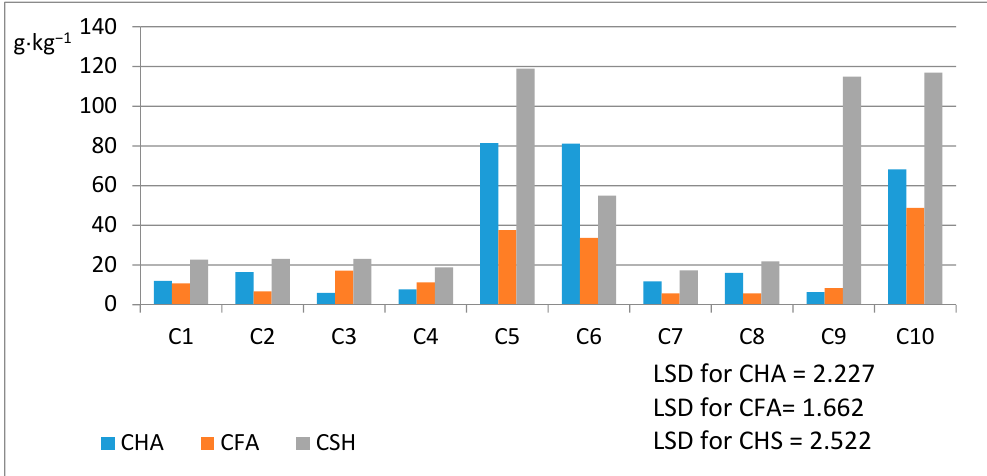
Figure 2. Contents of C HS , C HA , and C FA in analysed composts.